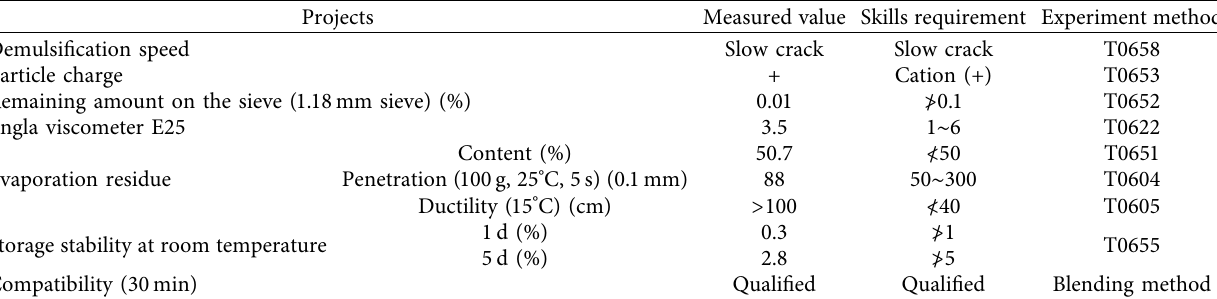
Table 2: Technical properties of BE-4 emulsified asphalt.